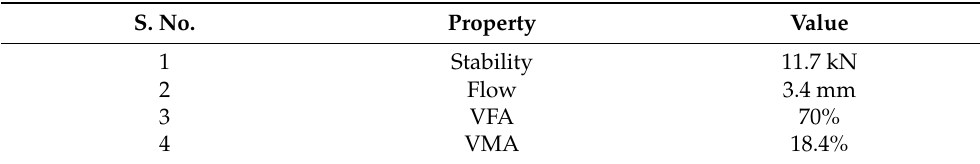
Table 7. Volumetric properties of HMA at